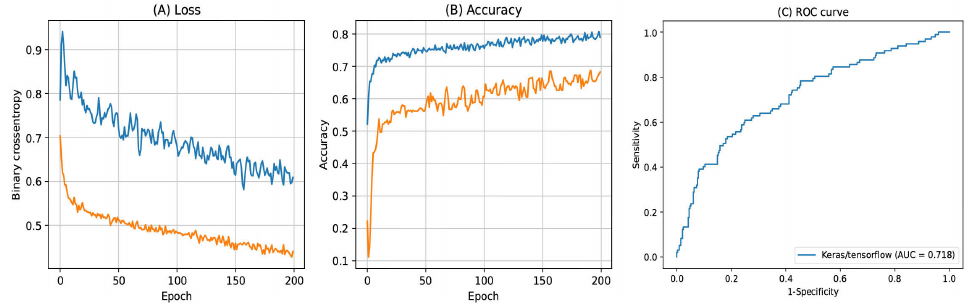
Figure 3. Differences in the area under the curve (AUC) based on whether ( A ) replacement driver variable was used or ( B ) not.